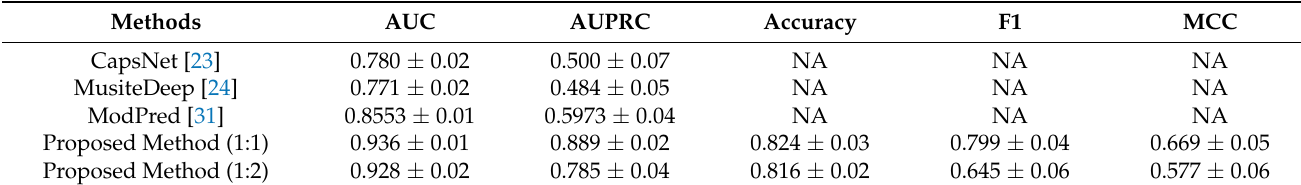
Table 3. Performance comparison with the state-of-the-art methods for S-PALM